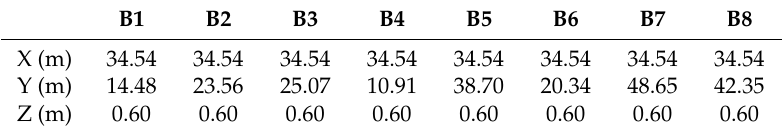
Table 12. The coordinates of gas sensor in optimal deployment scheme based on DE algorithm.